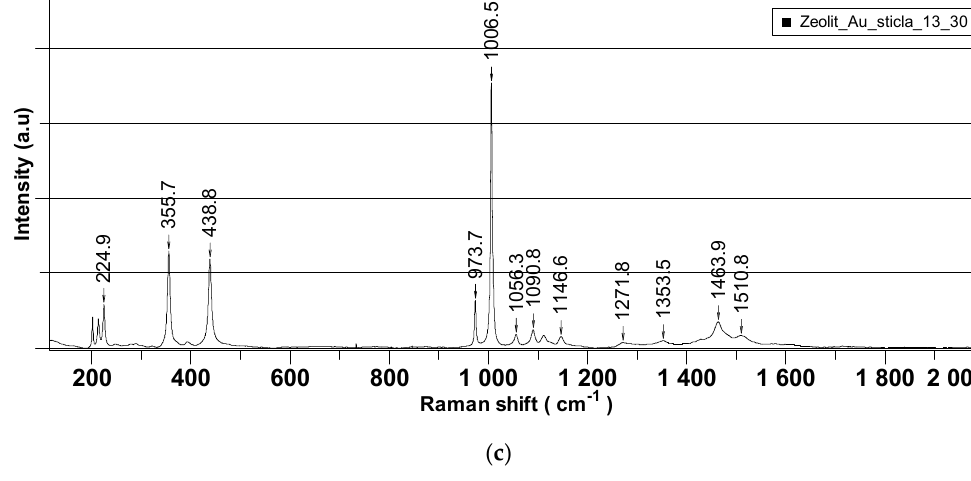
Figure 5. RAMAN spectra of the synthesized nanoparticles: ( a ) ZnO, ( b ) TiO 2 , and ( c ) zeolite.